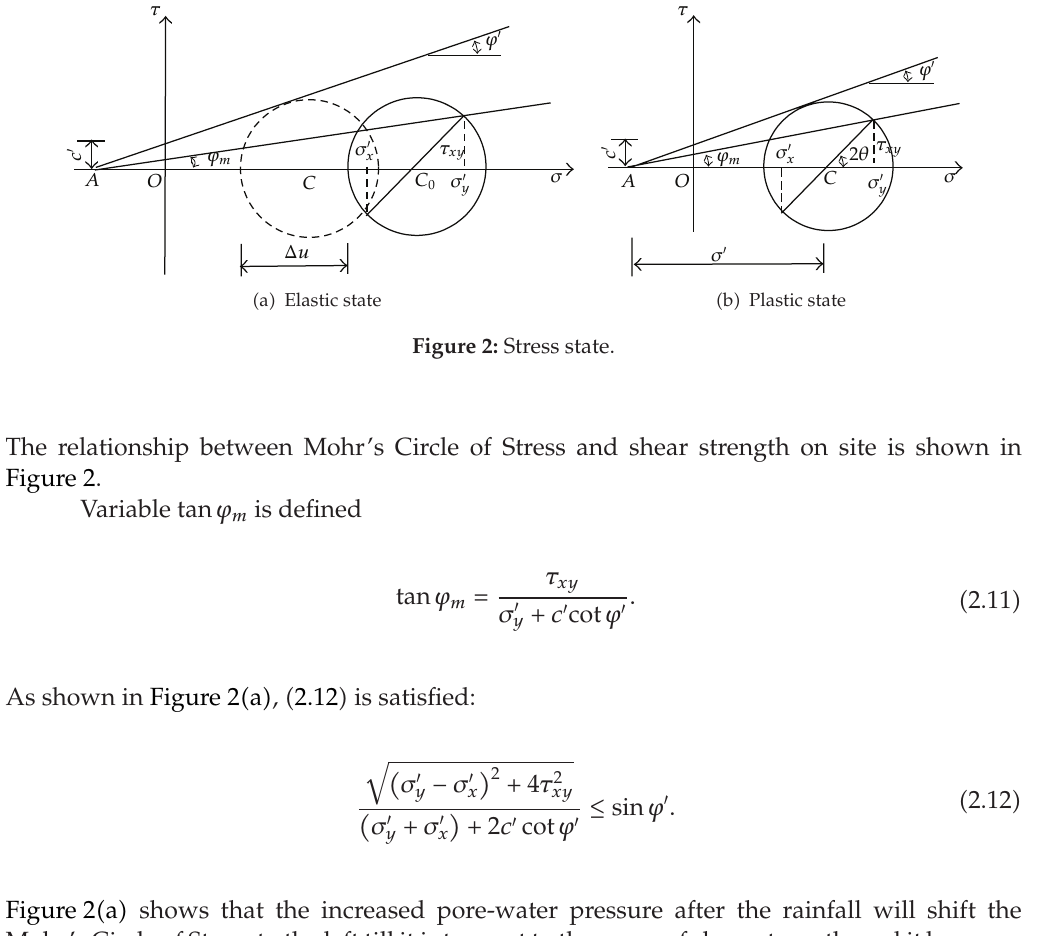
Figure 2 (cid:4) a (cid:5) shows that the increased pore-water pressure after the rainfall will shift the Mohr’s Circle of Stress to the left till it is tangent to the curve of shear strength, and it becomes yield at this site, then inequation (cid:4) 2.12 (cid:5) will become equation. However, the yield surface due to yield point does not parallel the bottom plane of slope at this moment (cid:4) Figure 2 (cid:4) b (cid:5)(cid:5) ; direction of principal stress axis will change with increased pore-water pressure until become parallel to the bottom plane of slope. During this period, stress of plastic zone can